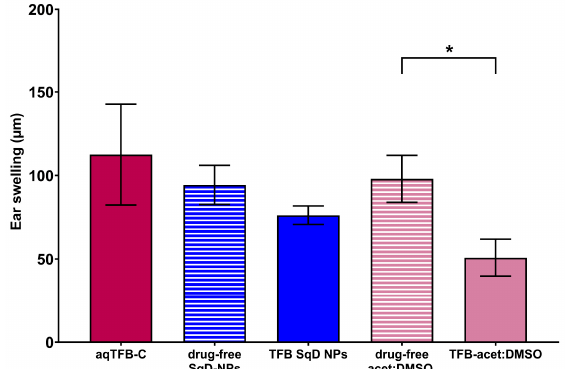
Figure 5. Ear swelling reduction in in vivo allergic dermatitis mouse model after 24 h allergen challenge. Application of formulation 30 min prior and 4 h after challenging. Tested treatment groups are: aqTFB-C (filled dark red bar), TFB SqD NPs (filled dark blue bar), including control group drug-free SqD NPs (striped dark blue bar), and TFB-acet:DMSO (filled purple bar), including control group drug-free acet:DMSO (striped purple bar). Results are presented as mean ± SEM. Significant di ff erence between vehicle control group and treatment group was tested by an unpaired two-tailed t -test. Significance levels are reported as p ≥ 0.05: n.s. and p = 0.01 to 0.05: